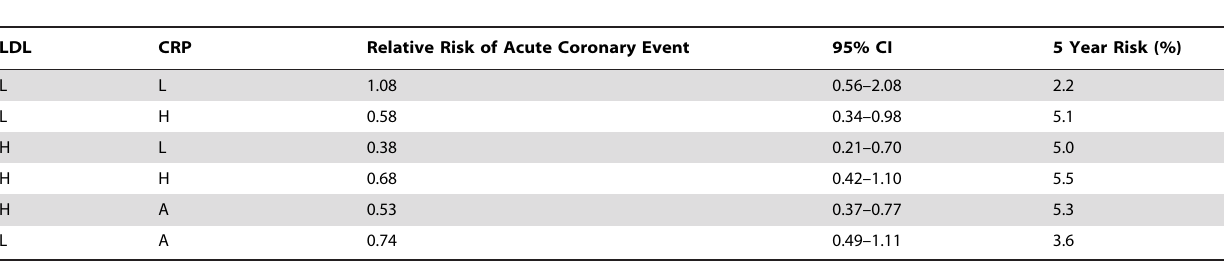
Table 3. AFCAPS/TexCAPS acute coronary disease results - Relative risks (and 95% CIs) associated with lovastatin therapy, according to baseline lipid and C-reactive protein levels.